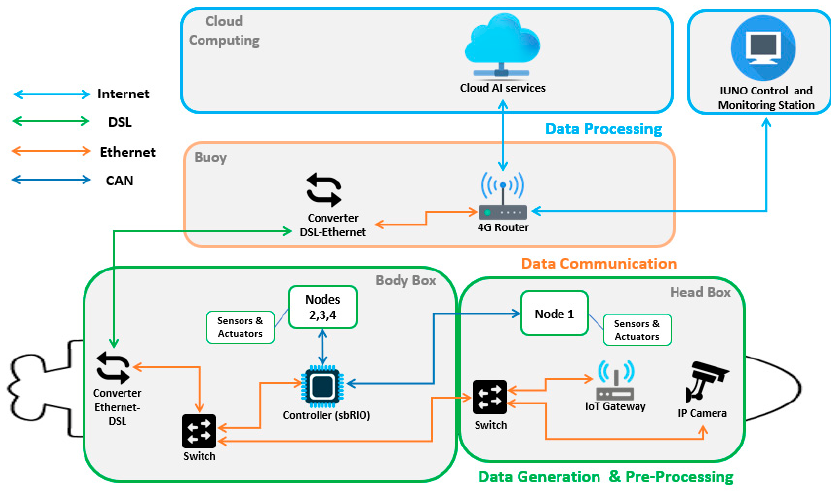
Figure 2. Proposed hardware architecture.